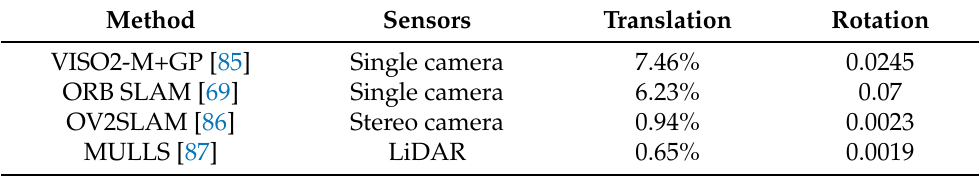
Table 1. Comparison of performance of selected odometry/SLAM algorithms on Kitti dataset. Columns Translation and Rotation present translation and rotation errors appropriately.